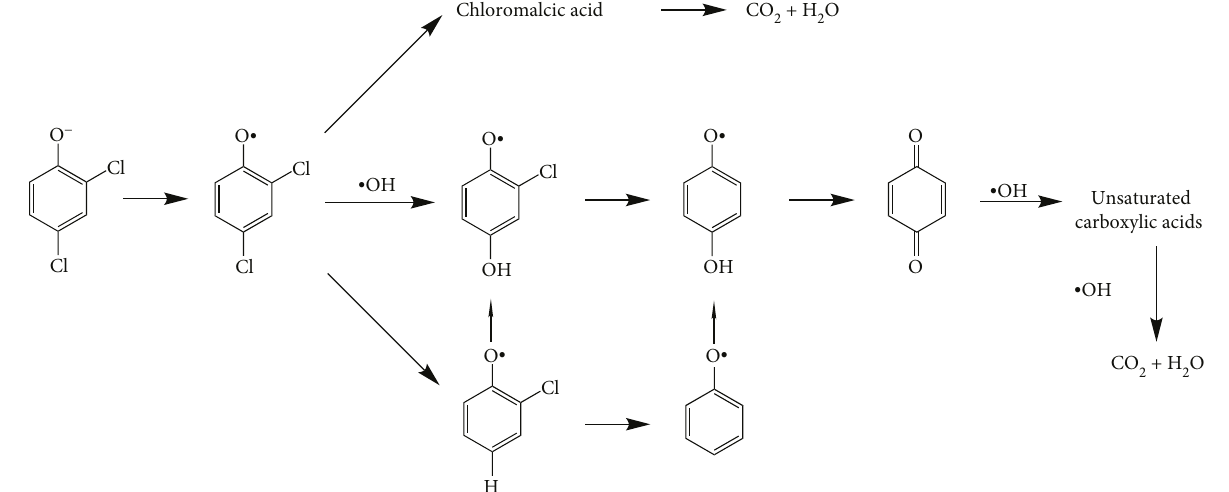
Figure 14: The pathway of decomposition of 2,4-DCP.